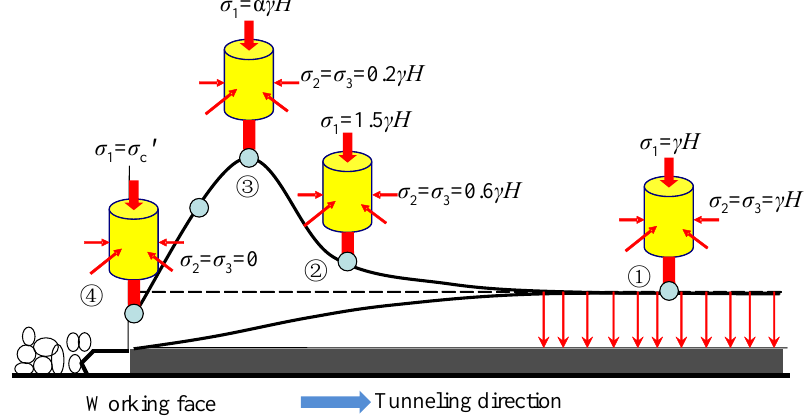
Figure 1. Abutment pressure evolution characteristics during mining process (modified after [36]).